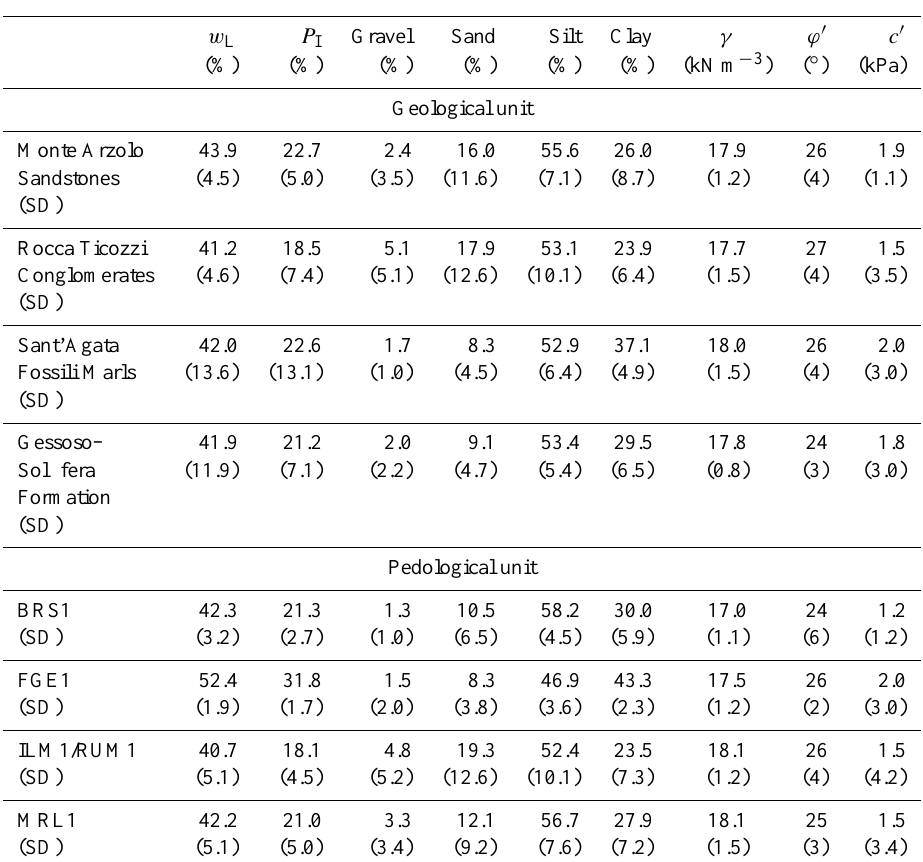
Table 3. Mean and standard deviation (SD) values of geotechnical and mechanical characteristics of the unit mapping of the soils of the study area. The SD values are in